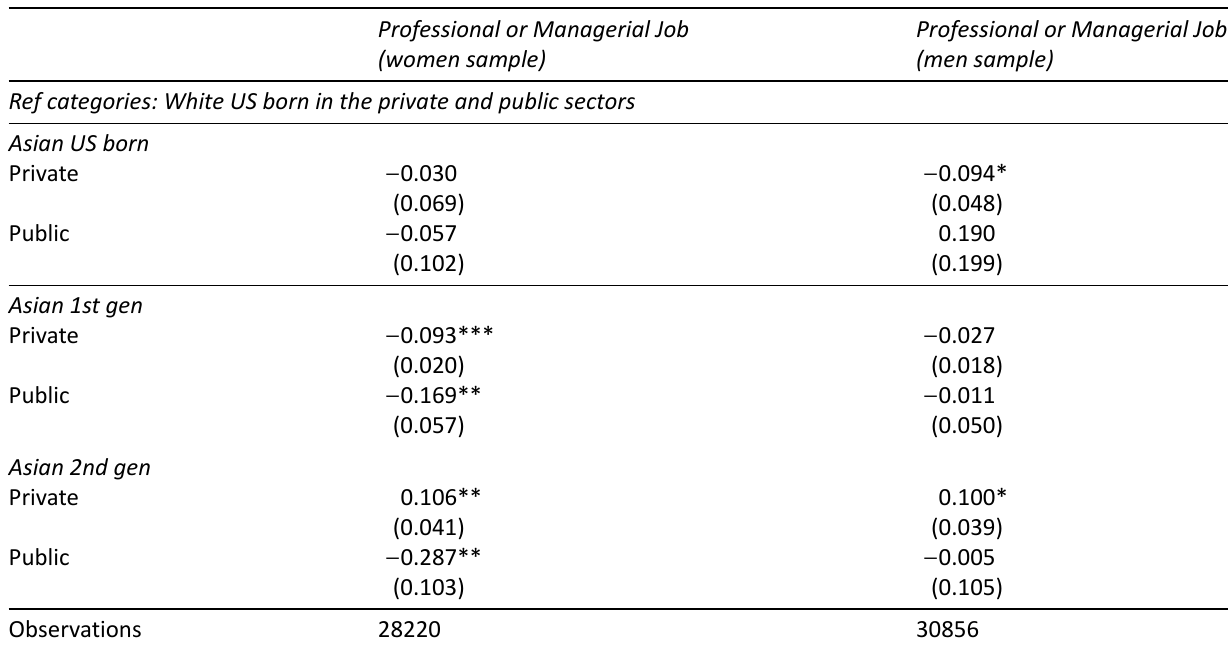
Table 4. (Cont.) Ethnic and migrant gaps in private and public sectors for professional or managerial jobs. Source: US Census Bureau